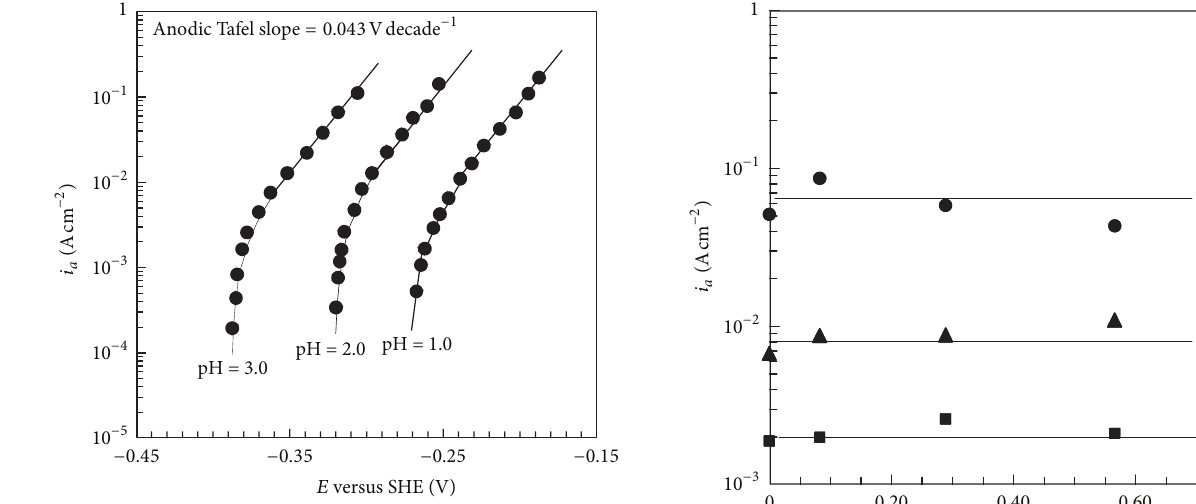
Figure 5: Anodic polarization curves of the specimen no. 3 in sulfuricacidsolutionsatpH=1.0,2.0,and3.0,withapotentialsweep rate of 0.01Vs −1 .